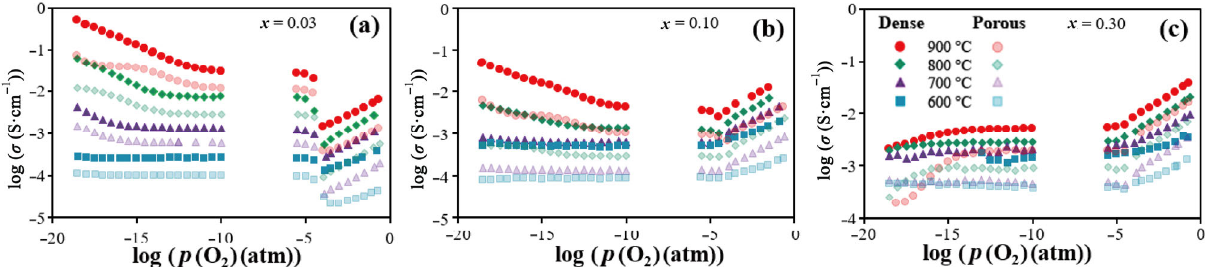
Fig. 10 Total σ of BaSn 1 − x Sc x O 3 − δ dense (solid symbols) and porous (faded ones) ceramic samples as a function of p (O 2 ) for (a) x = 0.03, (b) x = 0.10, and (c) x =